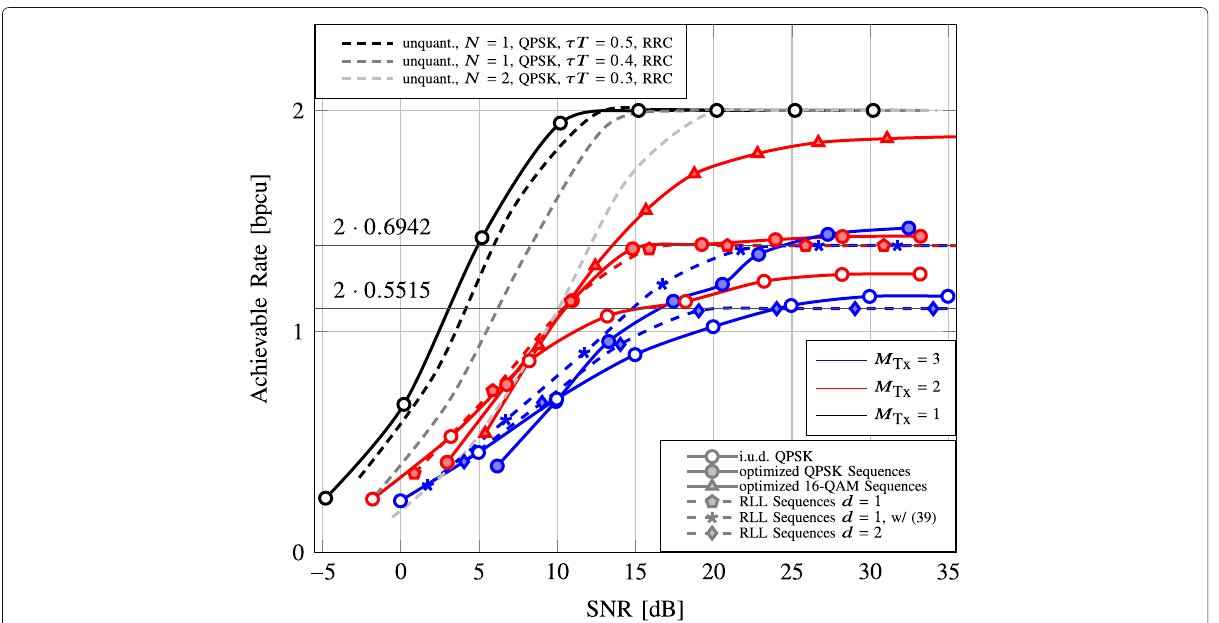
Fig. 15 Achievable rate with FTN signaling, M = 1, a channel use corresponds to time interval T s